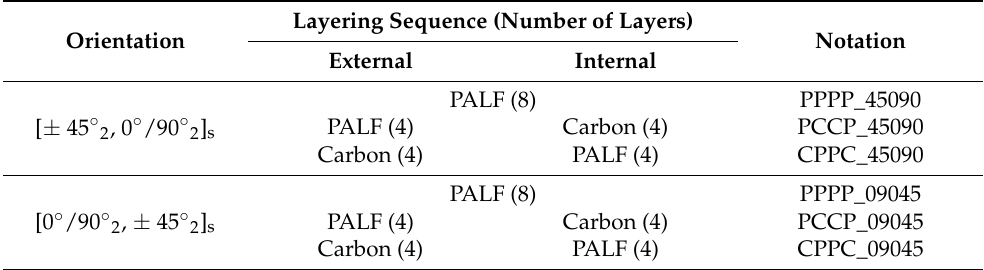
Table 3. Ply orientation and stacking sequence of the laminates: PALF (P) and carbon fibre (C).